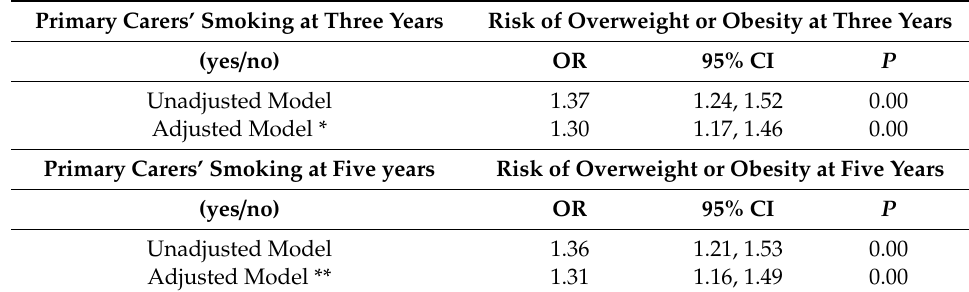
Table 2. * Adjusted odds ratios (ORs) (95% CI) for the impact of primary carers’ smoking at both waves. Primary Carers’ Smoking at Three Years Risk of Overweight or Obesity at Three